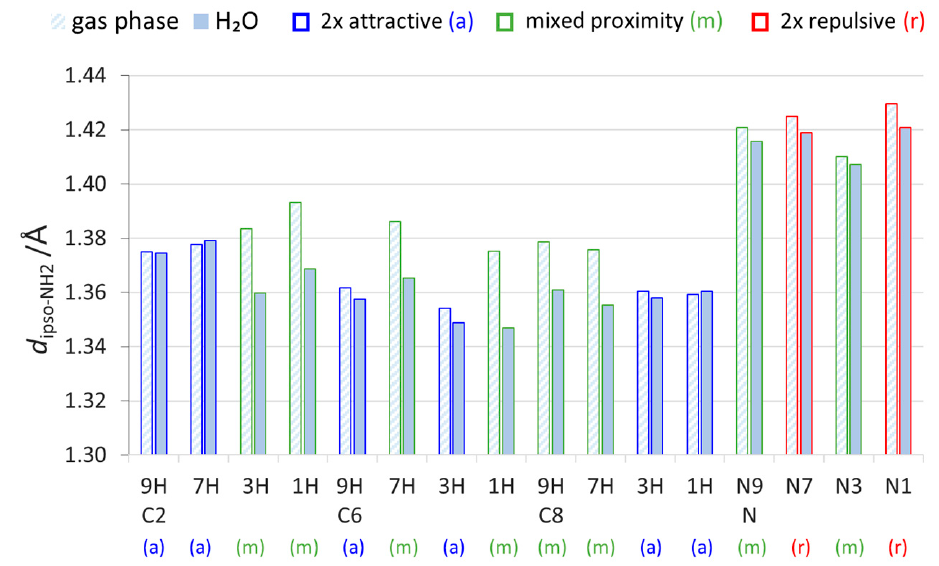
Figure 3. Lengths of bonds connecting the NH 2 with substituted C or N atom of purine moiety, d ipso-NH2 , in all studied aminopurines calculated in the gas phase and water (H 2 O). As mentioned earlier, solvation weakens the through-space proximity